Question: Condense the content of this figure into a single sentence.
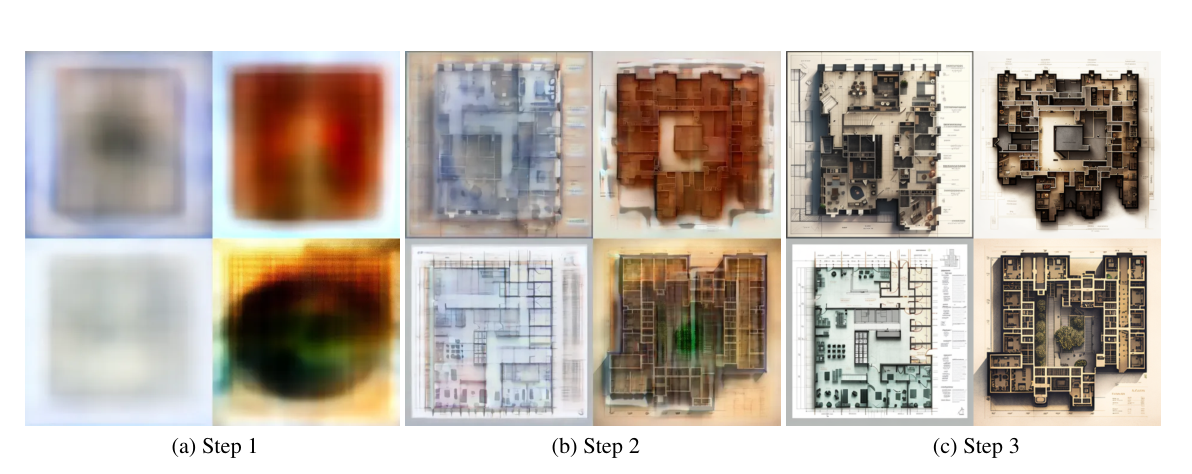
Answer: Examples of iterative denoising steps for a building floor plan in Midjourney v4.